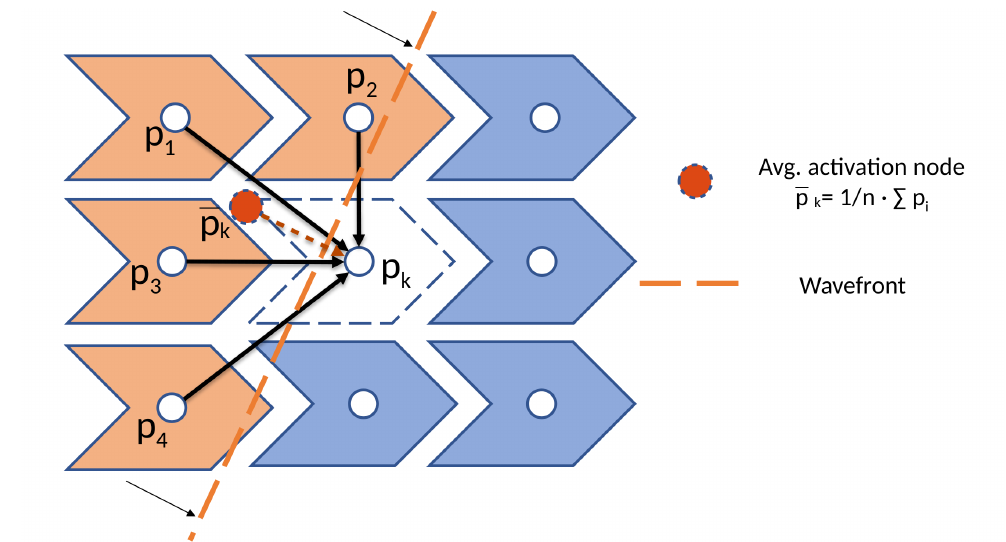
Figure 2. The activation time for a node is computed assuming a plane activation wavefront. Under this assumption, the activation time t a for node k can be computed from the average location of its k activating neighbor points ¯ p k and their average activation time ¯ t k as t a = t a + APD t d i , being APD i the APD of node i . In order to add the dynamic i i